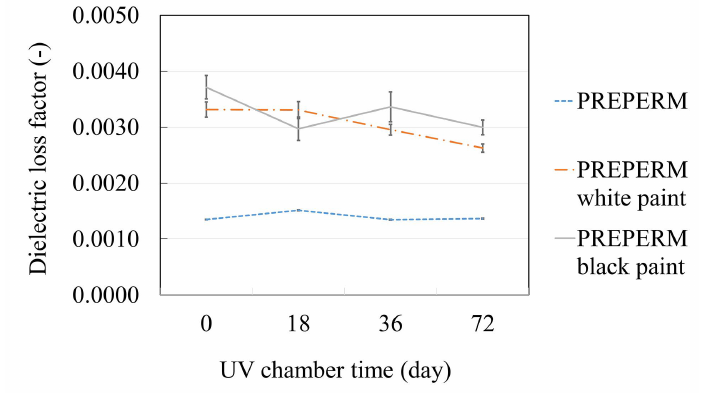
Figure 12. Measured attenuation in terms of DL; results over the 72-day accelerated UV-ageing